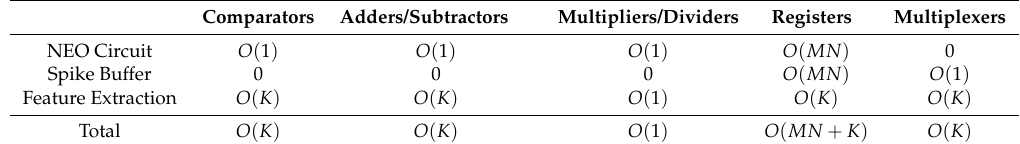
Table 2. The area complexities of the proposed spike sorting circuit.